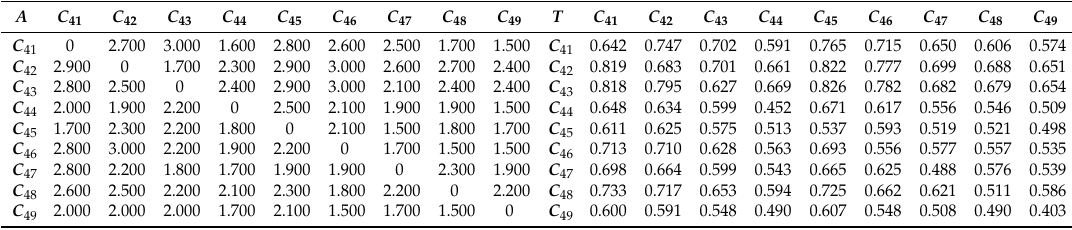
Table 5. The Average-direct influence relation matrix and total influence relation matrix of criteria in D 4